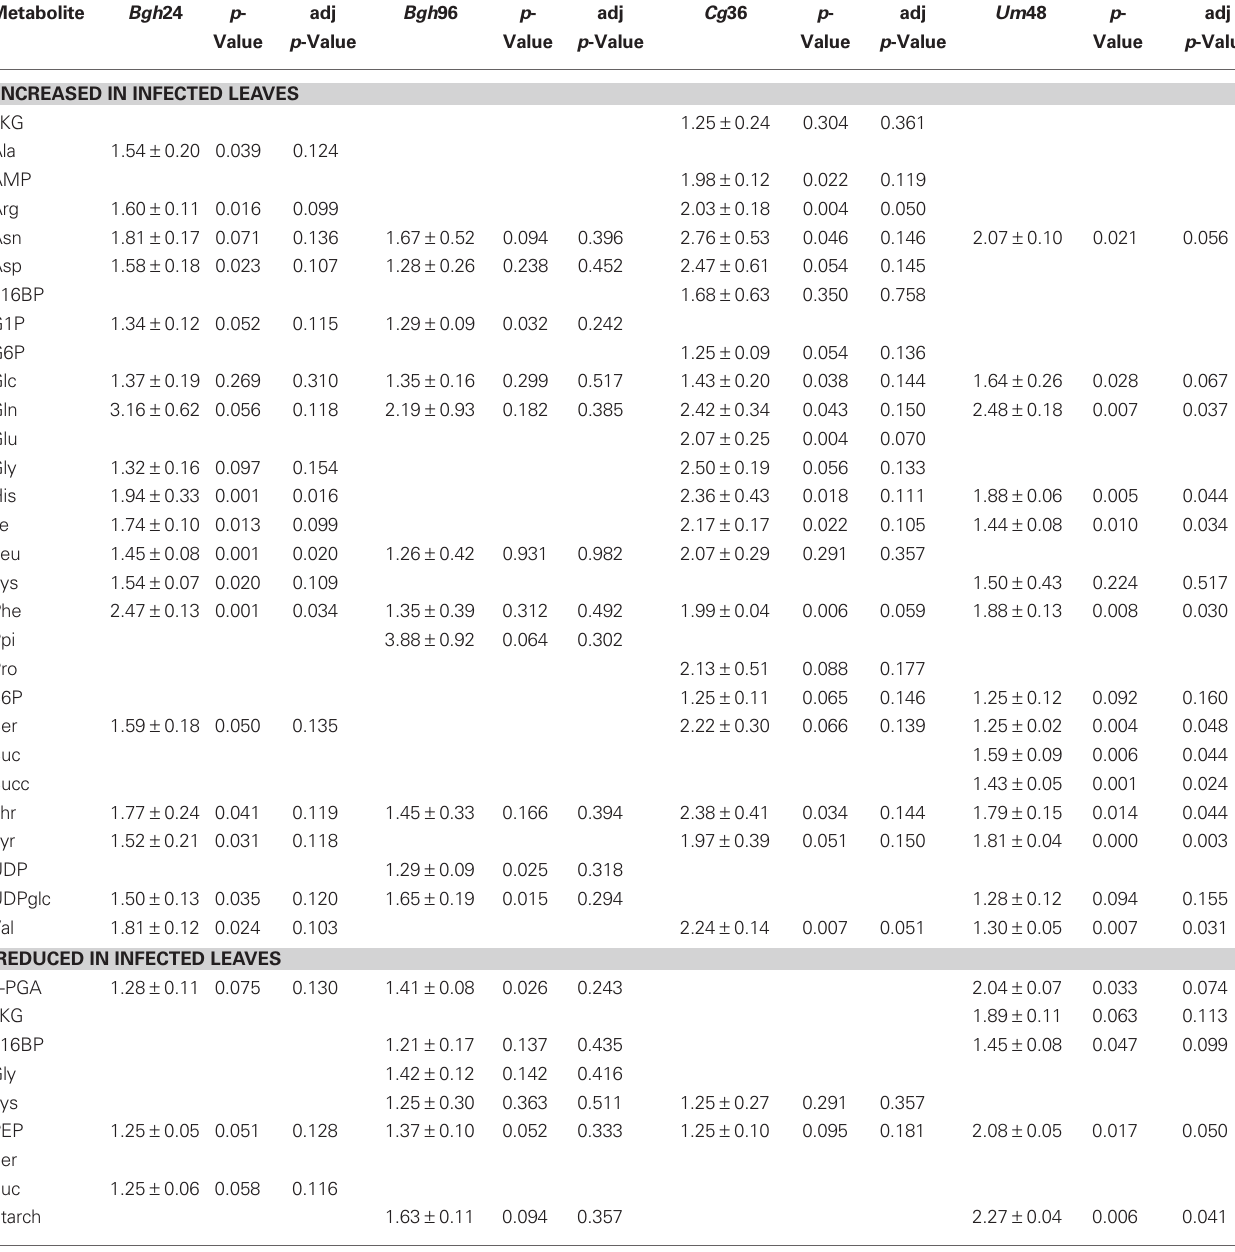
Table 2 | compilation of all substantial metabolite changes at biotrophic interaction time points.